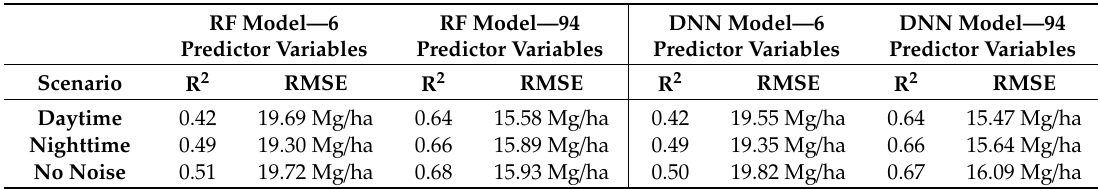
Table 3. Comparison of RF predicted AGB with AGB predicted from DNN models under three scenarios; no noise, daytime, and nighttime scenarios.